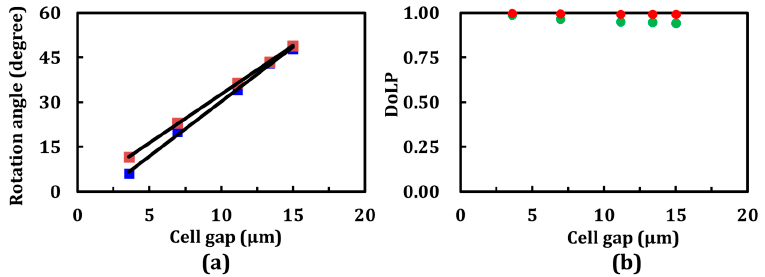
Figure 2. ( a ) Experimental and simulation results of the rotation angle as a function of the cell gap; ( b ) the DoLP (degree of linear polarization) values of the experimental results, shown in ( a ), as a function of the cell gap.